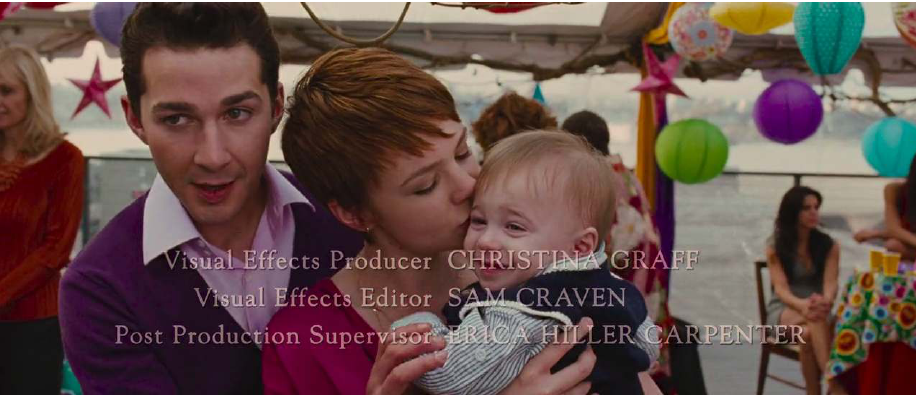
Source: Wall Street: Money Never Sleeps by Oliver Stone (screen